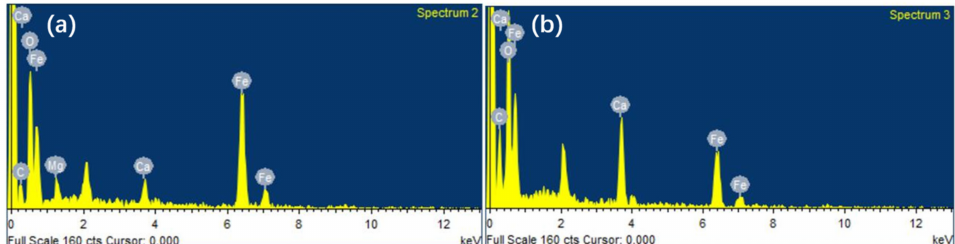
Figure 12. Energy spectrum with and without cow dung (( a ) without cow dung ( b ) with cow dung).